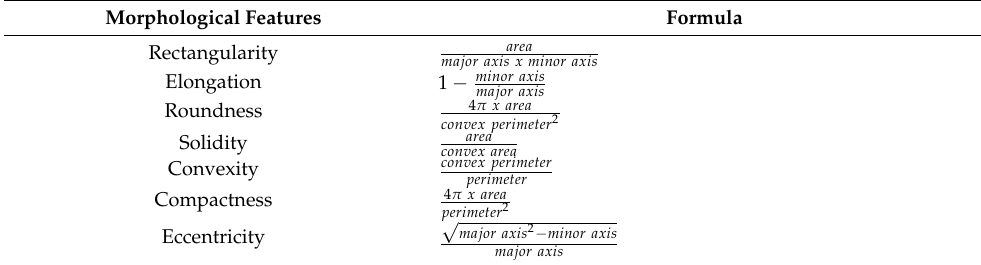
Table 2. Overall morphological features